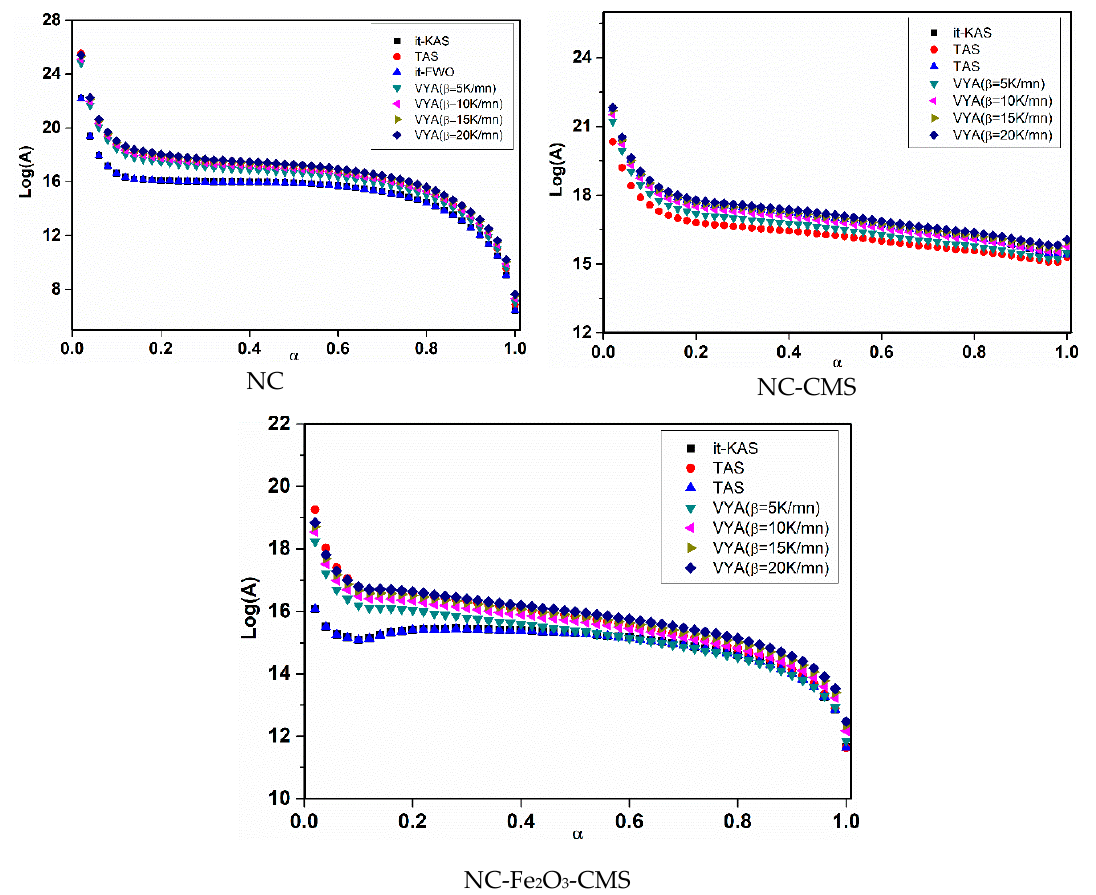
Figure 9. Pre-exponential factor evolution) for the investigated systems by using the different kinetic methods.